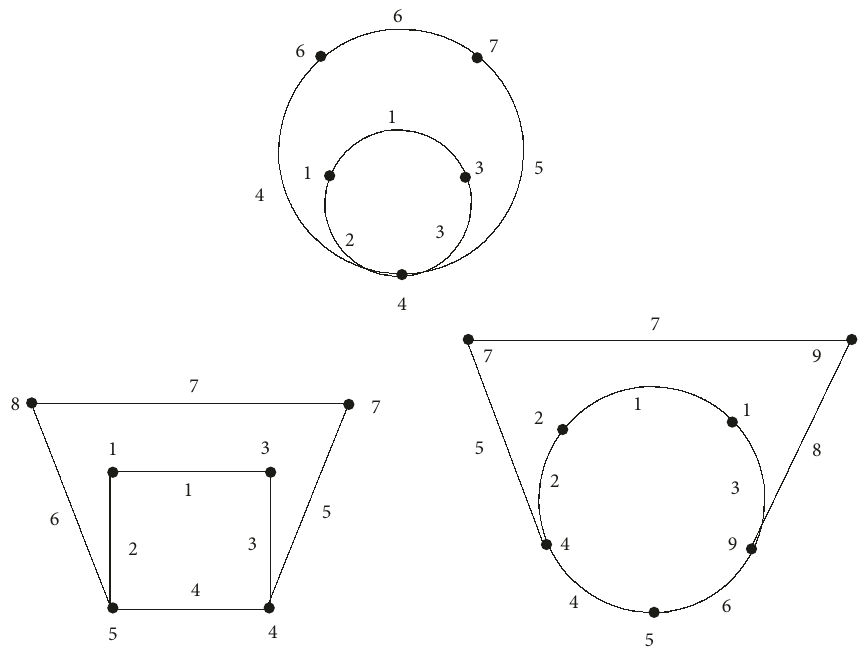
Figure 6: A classical mean labeling of the graph obtained by duplicating an edge of a graph C